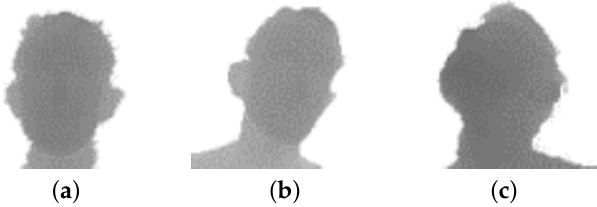
Figure 4. Sample frames taken from the subsets A 1 ( a ), A 2 ( b ), and A 3 ( c ) of the Pandora dataset, which contain frontal, non-frontal, and extreme head poses. See Section 4.1 for further